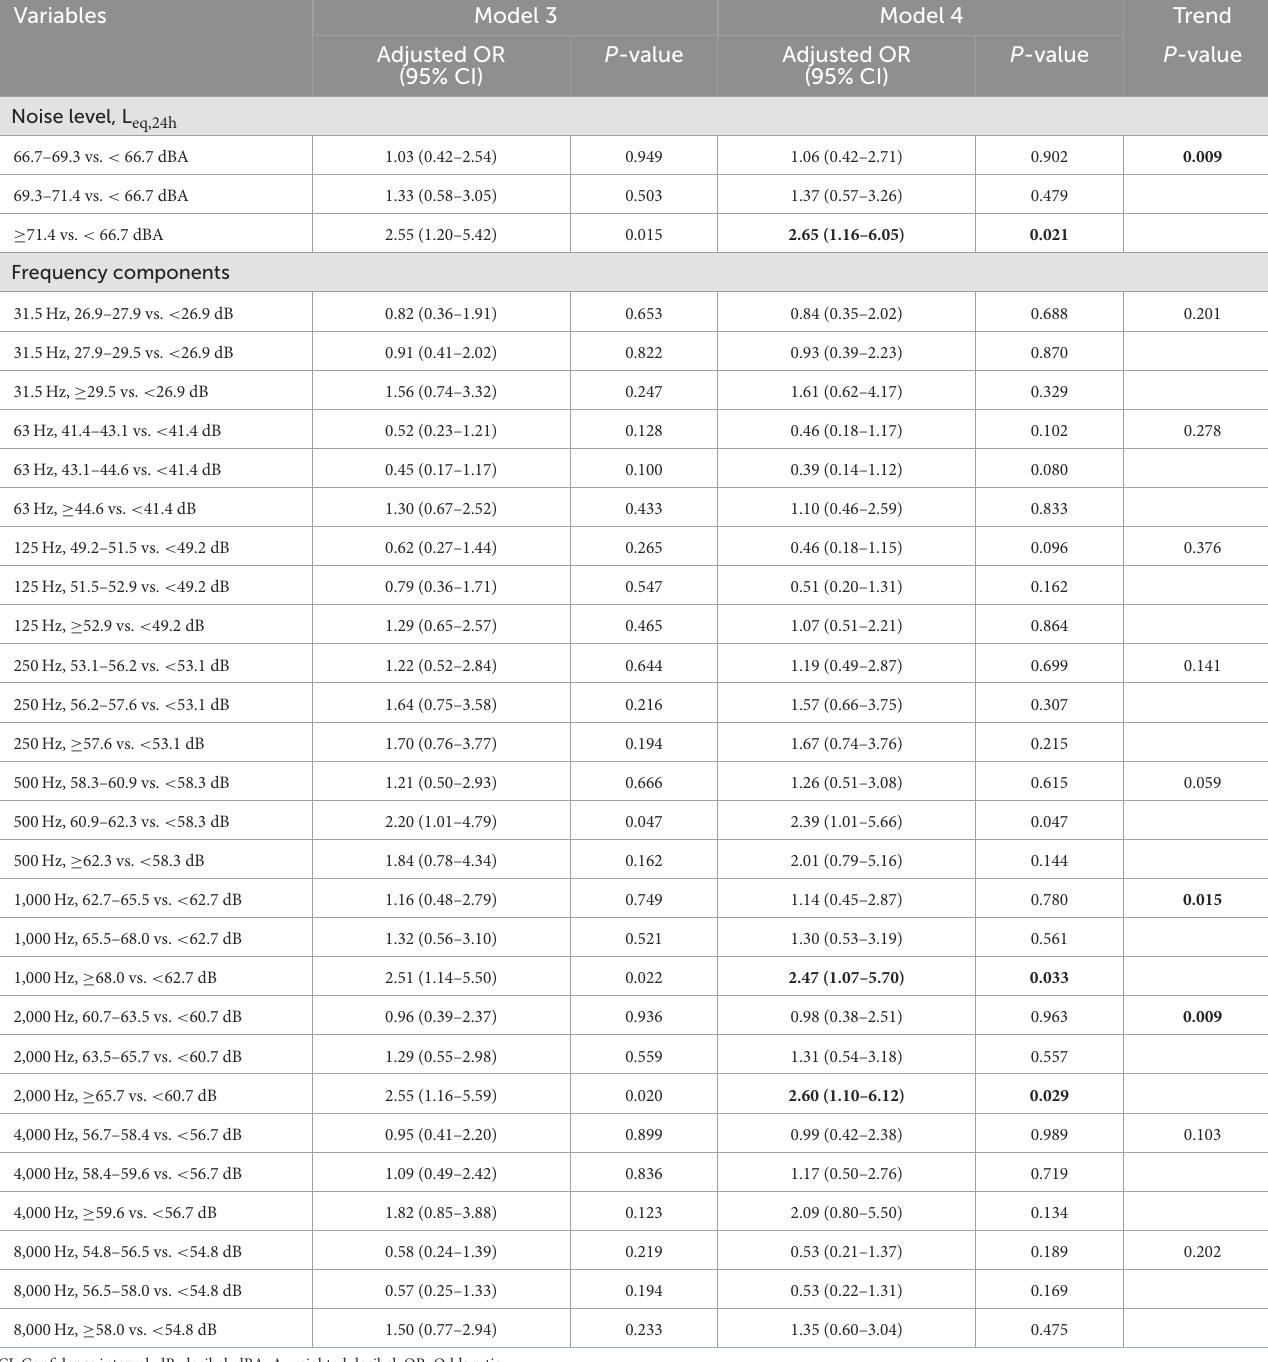
TABLE 5 Associations between different 24-h road traffic noise exposure groups (by quartile) and prevalent